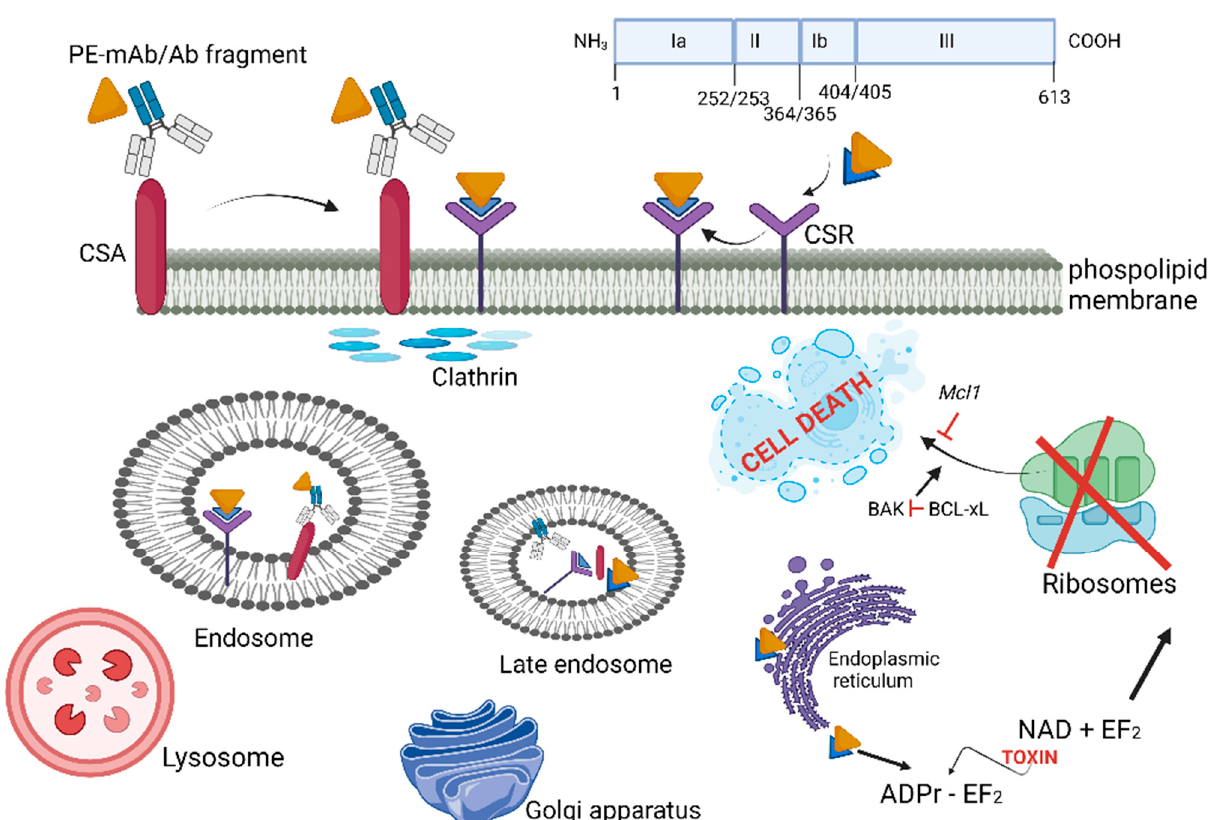
Figure 4. Top of presentation: The four domains (Ia, II, Ib and III) of Pseudomonas exotoxin (PE), with the sizes of each domain indicated in amino acid numbers. Interaction of PE-IT (immunotoxin) with a cancer-specific antigen (CSA) or cancer-specific receptor (CSR) on the surface of cancer cells. Intracellular events leading to cell death is illustrated below the phospholipid membrane. Abbreviations: PE-L = Pseudomonas exotoxin A, fused to a cancer-specific ligand; Ab = antibody; EF2 = eukaryotic elongation factor-2 on ribosomes; Mcl1 = gene encoding anti-apoptotic protein; BAK = Bak protein involved in mitochondrion outer membrane (MOM) permeabilization; BCL-xL = B-cell lymphoma-extra large that inhibits the activation of Bak, thereby preventing a loss of MOM integrity. This illustration was constructed using BioRender (https://biorender.com/, accessed on 15 August 2022).